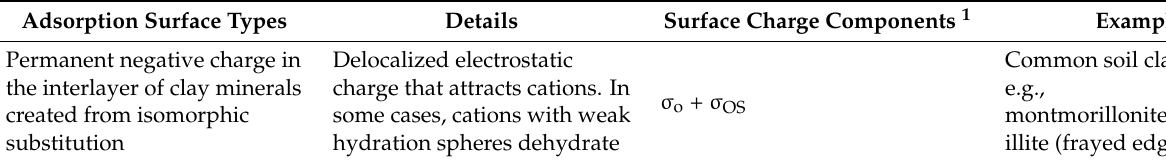
Table 2. Types of adsorption sites on minerals and the surface charge components.